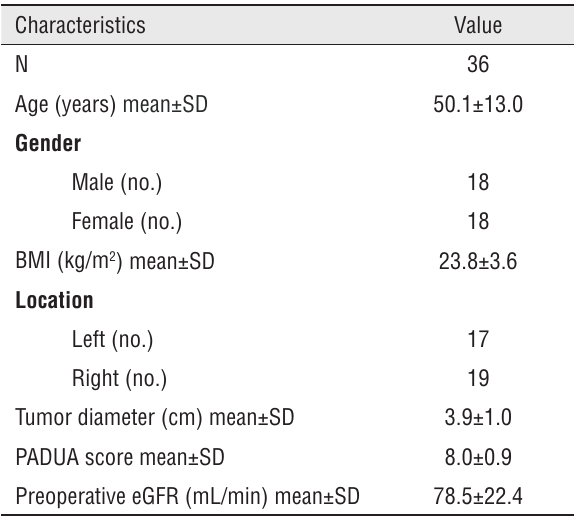
Table 1 - Demographic